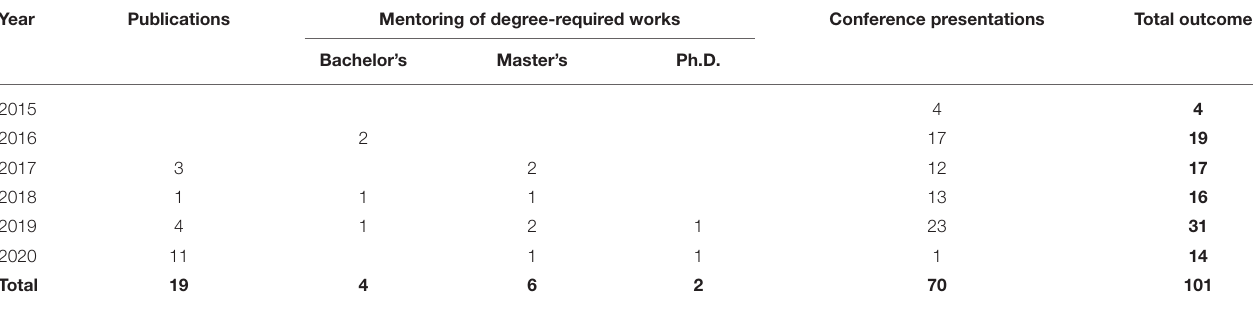
TABLE 3 | Co-produced publications, degree-qualifying works, and conference presentations between 2015 and